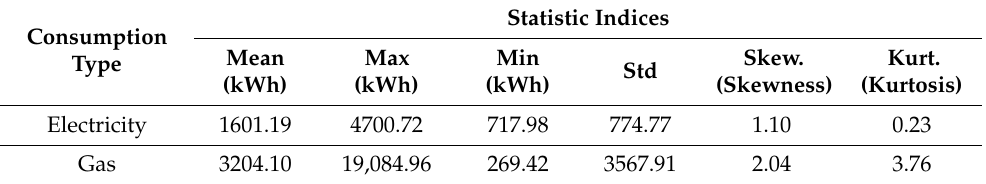
Table 2. Basic statistics of energy consumption data of UK office buildings in